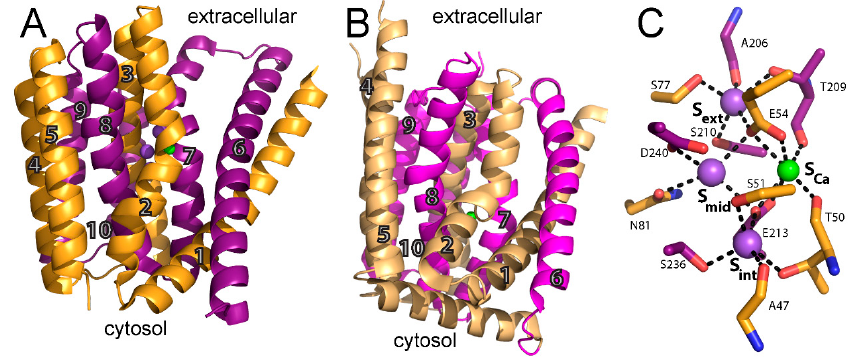
Figure 1. Structure of NCX_Mj ( Methanococcus jannaschii sodium–calcium exchanger). ( A ) crystal structure of outward-facing NCX_Mj (PDB 3V5U) in cartoon representation. Helices 1–5 (TM1–5) are orange and helices 6–10 (TM6–10) are purple . Purple and green spheres represent Na + and Ca 2+ ions, respectively; ( B ) crystal structure of inward-facing VCX1 (PDB 4K1C) in cartoon representation. Helices 1–5 (TM1–5) are light orange and helices 6–10 (TM6–10) are magenta . Green sphere represents Ca 2+ ; and ( C ) ion coordination as initially suggested by the crystal structure of NCX_Mj (PDB 3V5U). Ion coordinating residues are shown as sticks. Purple and green spheres represent Na + and Ca 2+ ions, respectively.